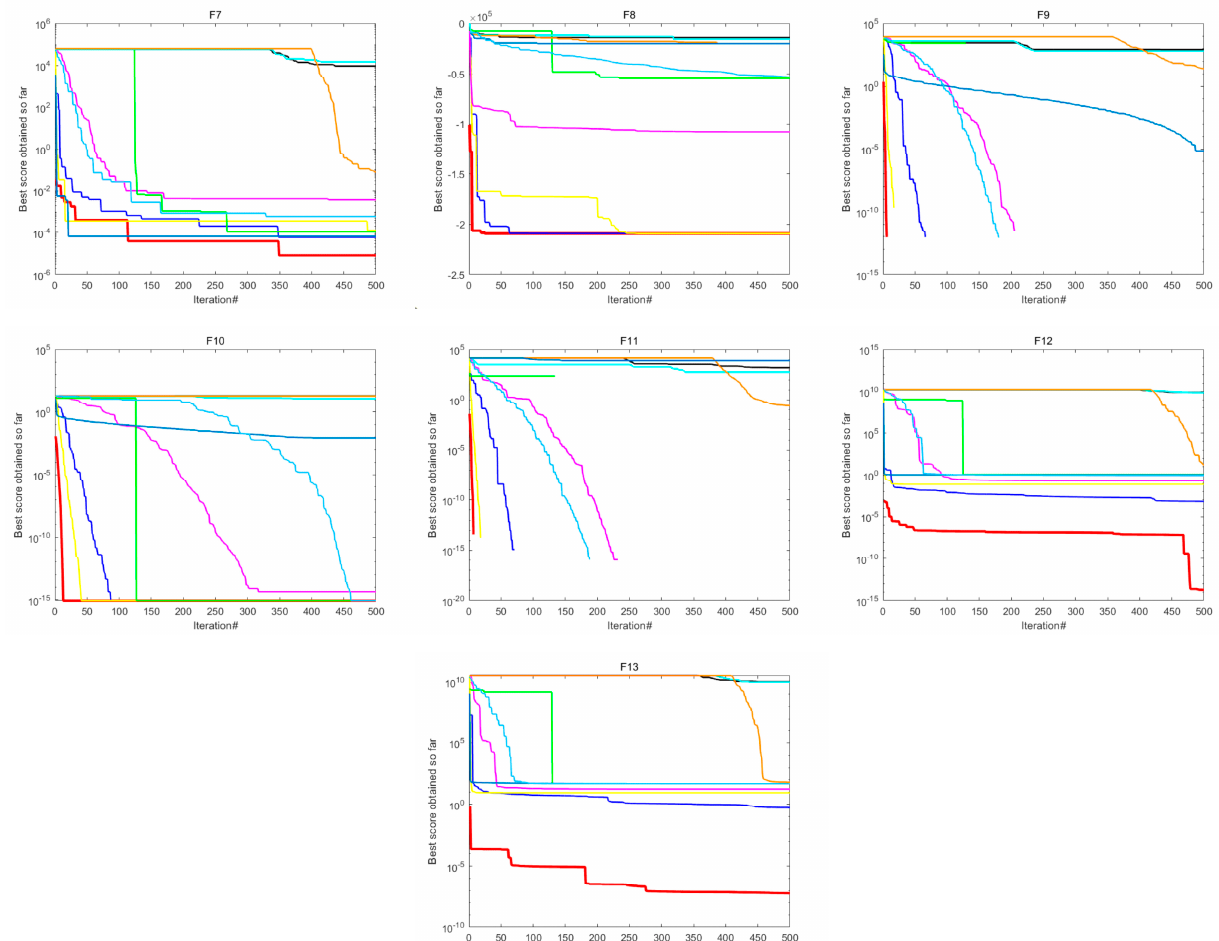
Figure 4. Convergence curves for the optimization algorithms for standard benchmark functions (F1–F13) with dim = 500.